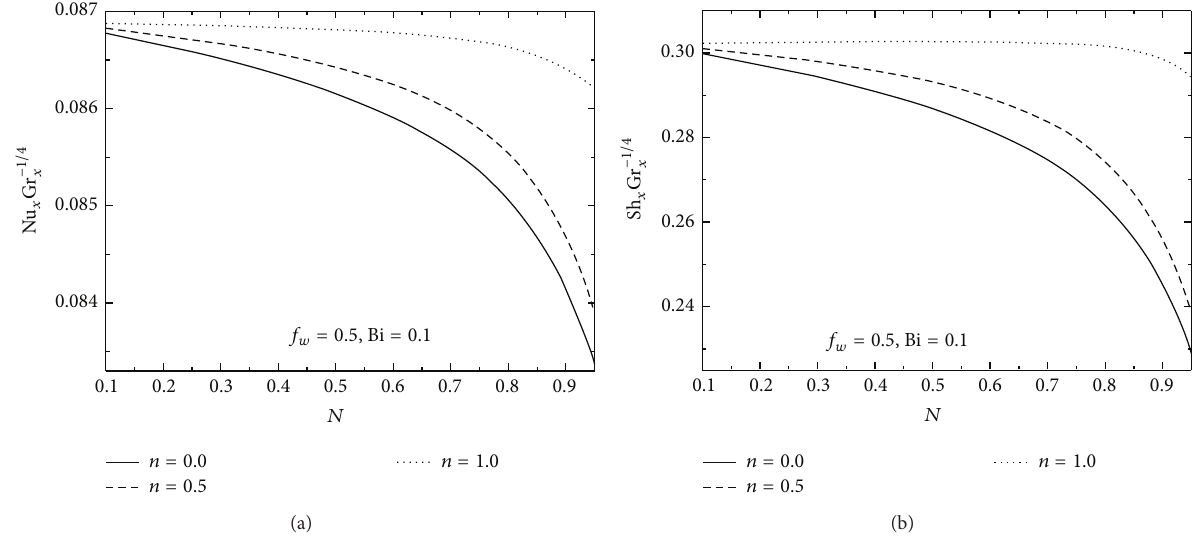
Figure 8: Effect of material parameter 𝑛 on (a) heat transfer rate and (b) mass transfer rate.